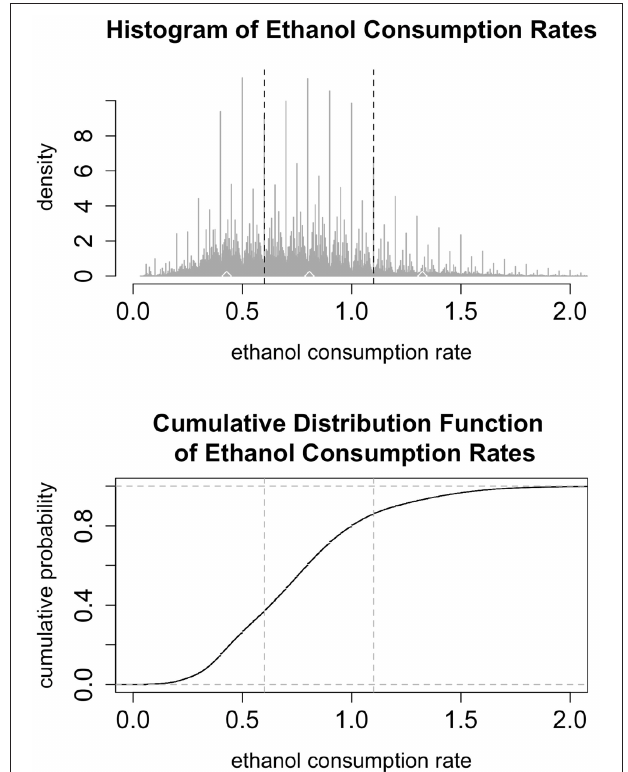
FIGURE 3 | (Top) The histogram shows 22 h of drinking per day for a year for 31 monkeys, not including 1 s drinks at a rate less than or equal to 0.2 mL/s. The vertical black dashed lines denote breaks between the low, medium, and high categories: low drinking is (0, 0.6), medium is [0.6, 1.1], and high is above 1.1. The upper and lower cut-off for each bin were derived from the data by finding local minima in the (smoothed) histogram. The median values are marked by white diamonds: median low is 0.383, median medium is 0.798, and median high is 1.376. In the simulations, low, medium and high rates are set at these median levels. (Bottom) The cumulative distribution function of ethanol consumption rates plot presents another view of the same ethanol consumption rates data as in the upper panel. The vertical dashed lines represent the breaks between low, medium, and high drinking